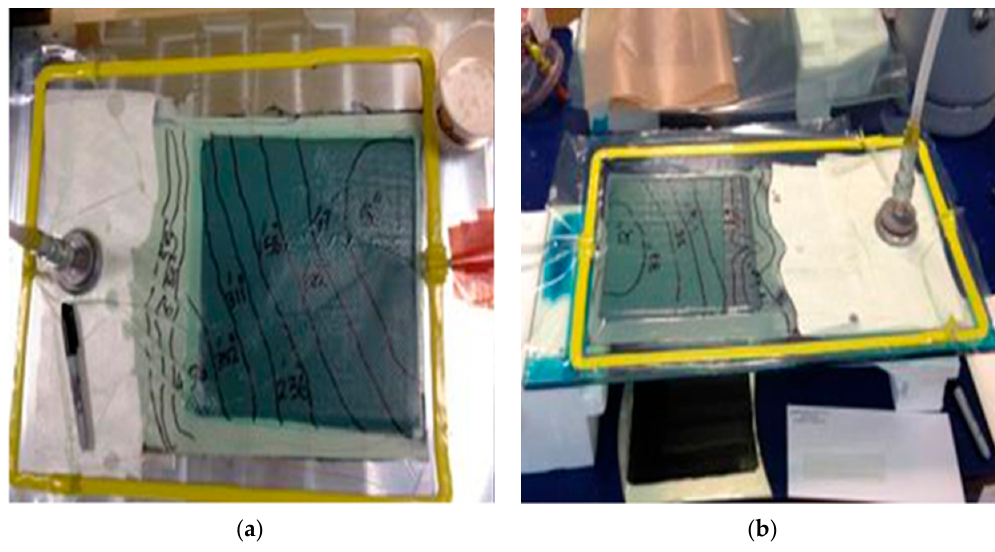
Figure 6. Vacuum Assisted Resin infusion set-up using: ( a ) Al plate; and ( b ) glass plate with a mirror below to trace the flow evolution.